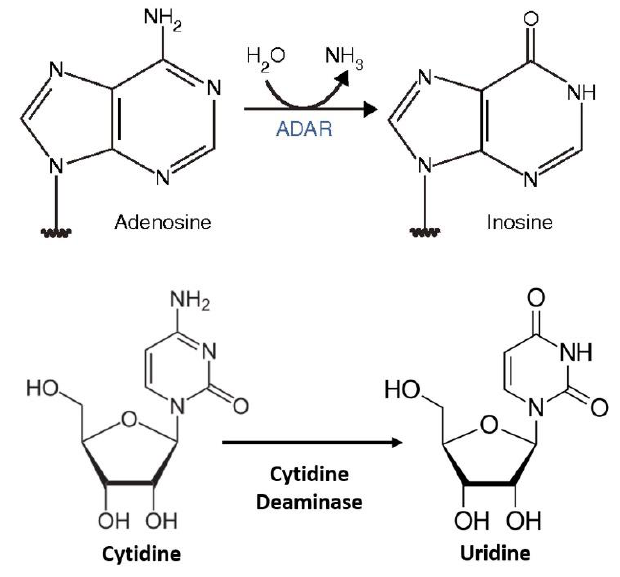
Figure 2. RNA editing (A to I and C to U) [18].